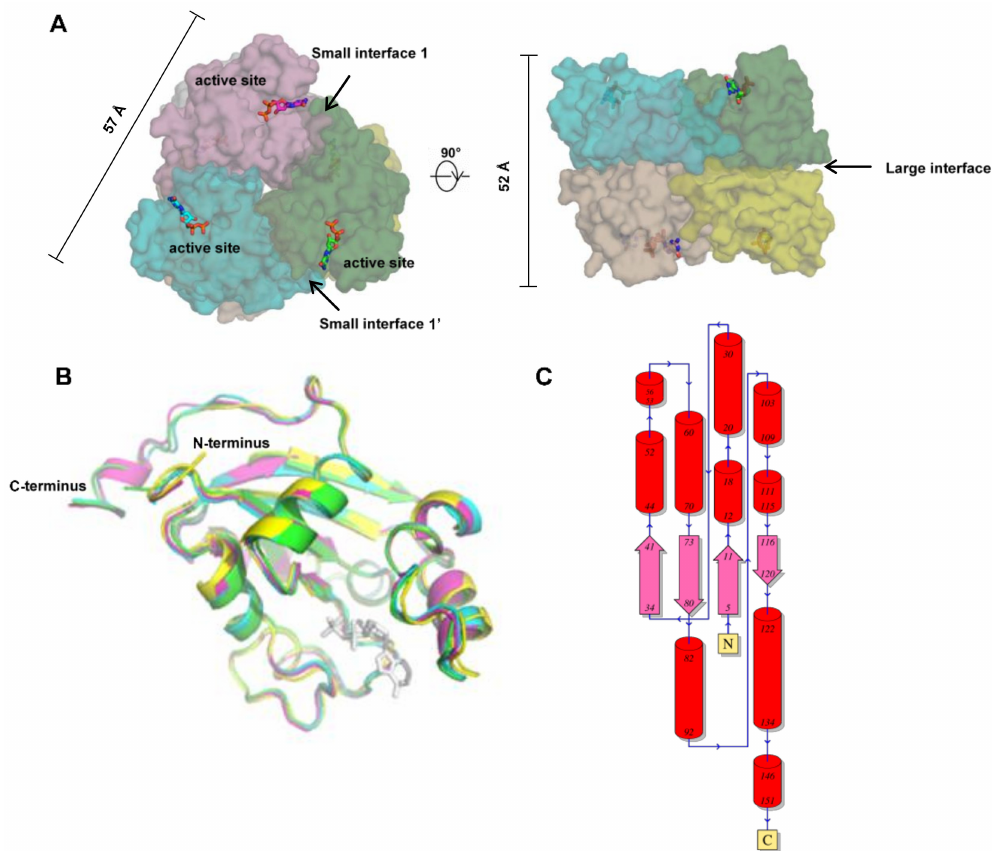
Figure 3. Structures of human NMEs. ( A ) Human NMEs 1-4 are hexamers with a D3 symmetry. Each subunit contains an active site, as represented with sticks. The six subunits are shown in di ff erent colors. Each subunit forms three interfaces with adjacent subunits, as indicated by arrows. The diameter (shown in the top view, left panel) and width (shown in the side view, right panel) are 57 Å and 52 Å, respectively. ( B ) Superimposition of human NME1–4 subunits (colored green, cyan, yellow, and magenta, respectively). A nucleoside diphosphate (NDP) substrate is shown in white sticks. ( C ) The topology of human NMEs, with helices represented by cylinders and strands by wide arrows. The topology of human NME1 is used as a representative (PDB ID: 1UCN, figure from